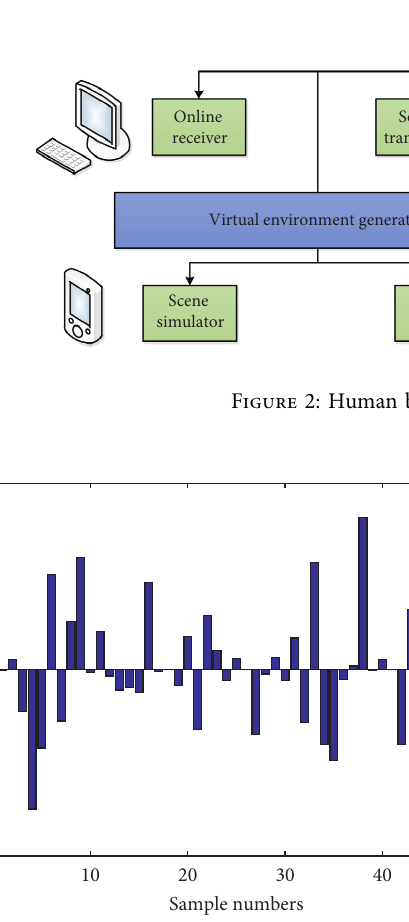
Figure 3: The output histogram of the decision model of the human science system.